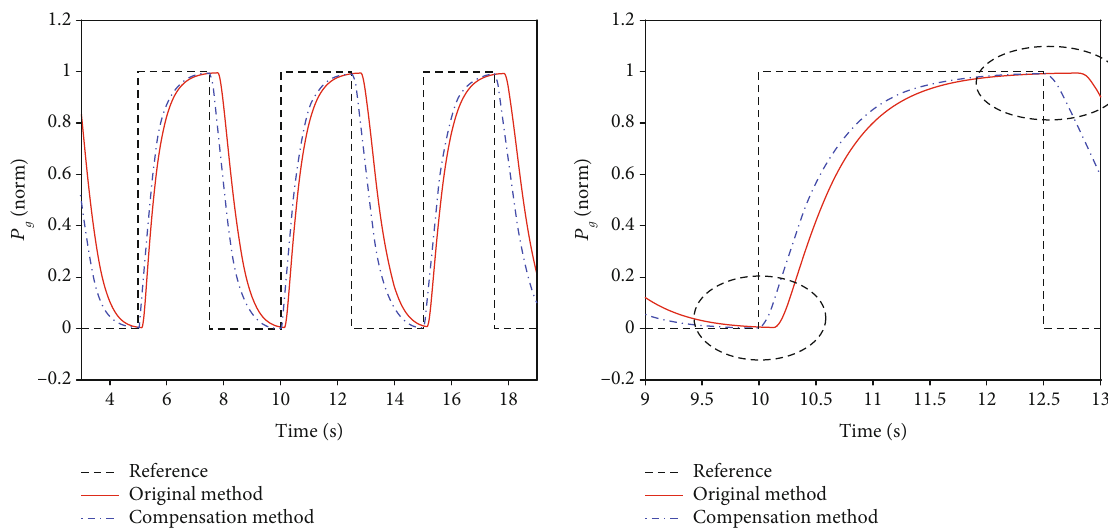
Figure 12: Simulation result of backlash compensation in a constant case.